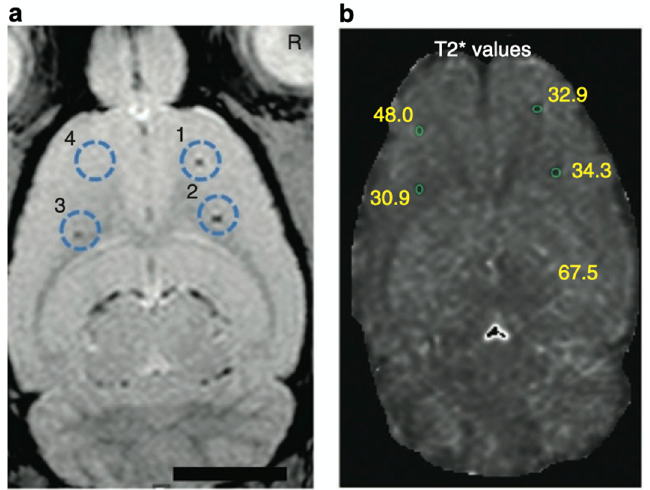
Figure 6. In vivo magnetic resonance visualization of intracranially implanted cells labeled with heparin–protamine–ferumoxytol complexes. ( a ) A magnetic resonance image. Circles indicate injection sites of the labeled cells. ( b ) Calculated T2* map with T2* values at each injection site. Adapted by permission from Nature Publishing Group: Springer Nature ref. [91], Copyright 2012.